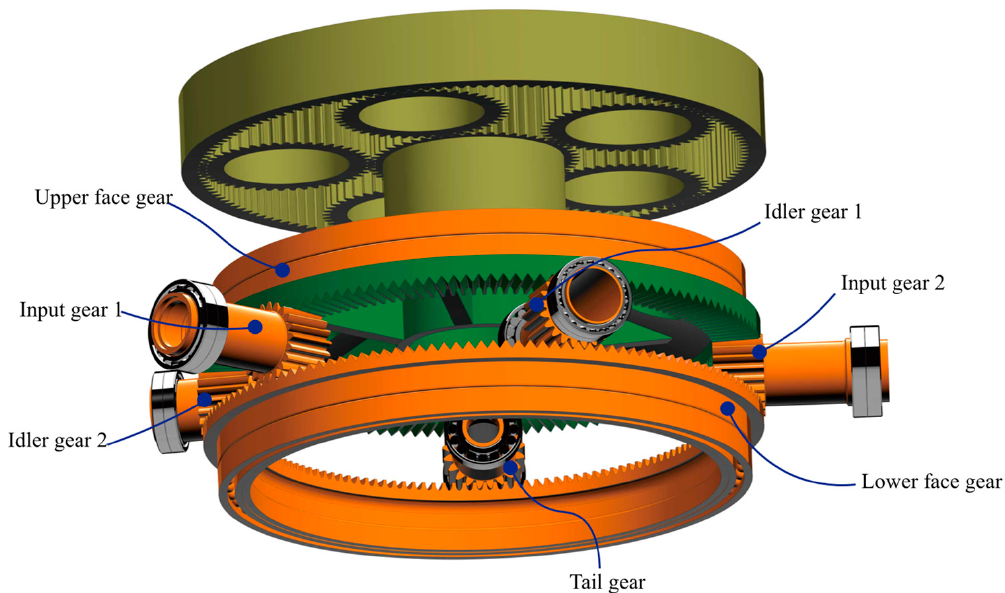
Figure 1. Schematic diagram of the concentric face gear split-torque transmission system.